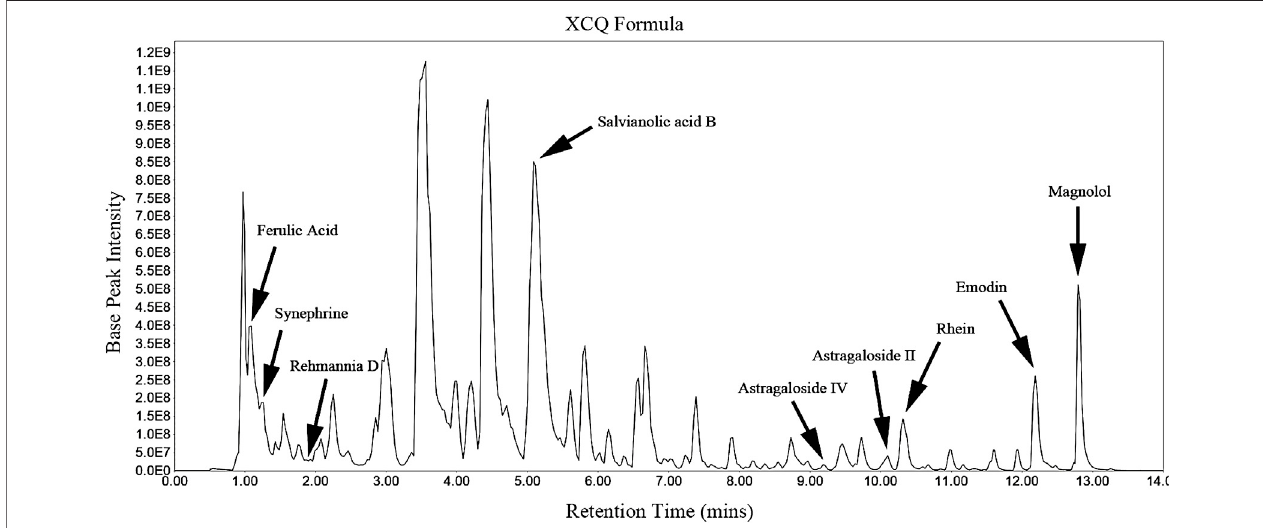
FIGURE 1 | HPLC chromatogram of the characteristics of the Xiao Chengqi (XCQ) formula: The chromatogram of bioactive active compounds derived from the XCQ formula, including Rhein, emodin, salvianolic Acid B, ferulic acid, astragaloside IV, astragaloside II, magnolol, Rehmannia D and synephrine.